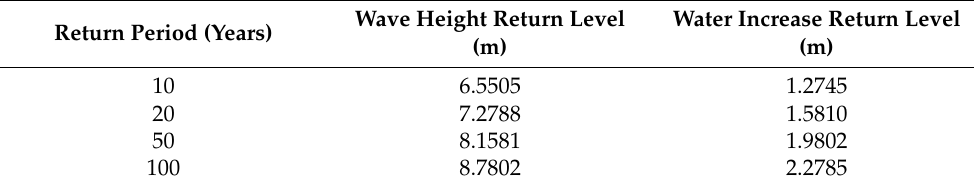
Table 6. The return level of wave height and water increase in different return periods based on EED-I type distribution.